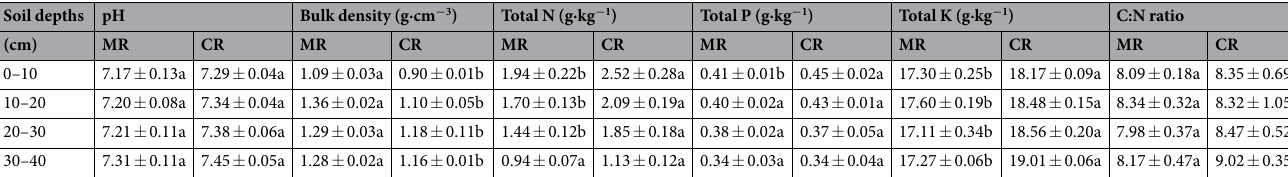
Table 1. Soil physicochemical properties under different treatments. MR, rice monoculture model; CR, Integrated rice–crayfish model. Means with different letters for the same property in the same soil layer indicate significant differences at p < 0.05. Values are means ± standard